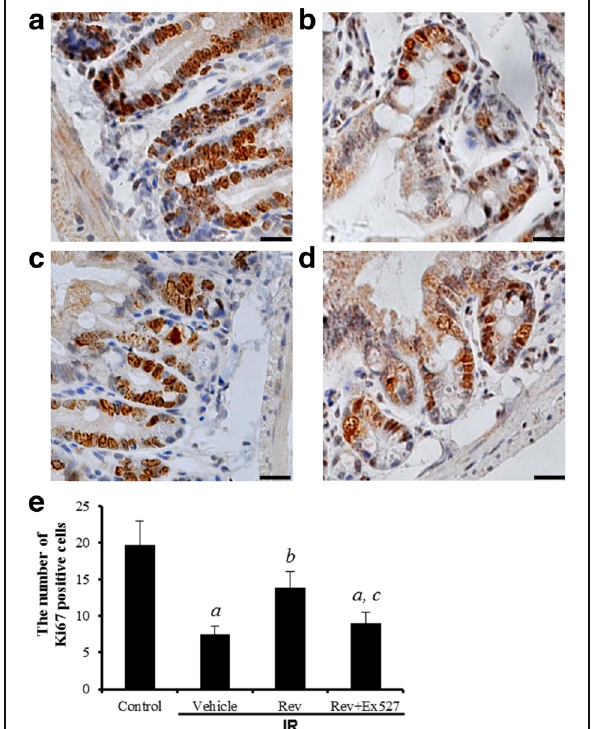
Fig. 2 Analysis of IHC of intestinal crypts stained with an antibody against Ki-67. a sham control mice, ( b ) vehicle-treated irradiation mice, ( c ) resveratrol treated irradiation mice, and ( d ) resveratrol plus Ex527 treated irradiation mice. (e) Bar graphs showing Quantitative analysis of the Ki-67 expression of crypt cells. The data are presented as means ± SE. n = 6 mice per group. a p < 0.01 vs control; b p < 0.05 vs IR; c p < 0.05 vs IR + Rev. Scale bar: 20 μ m